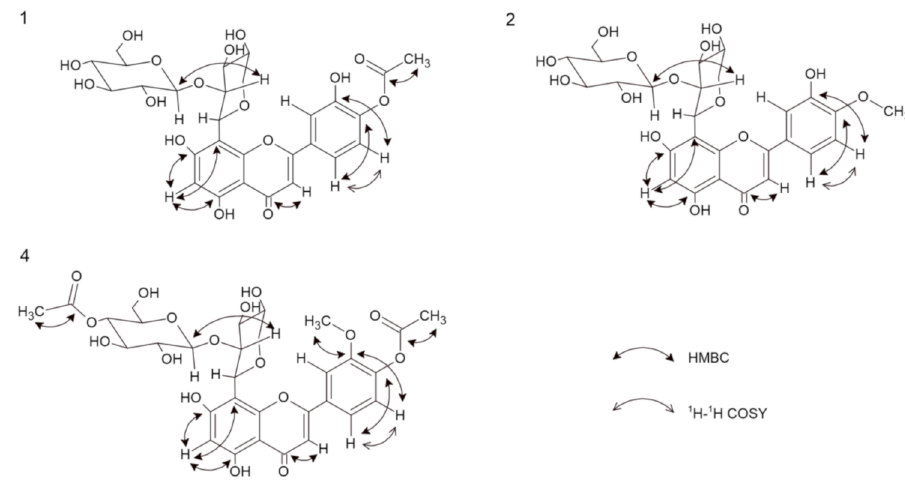
Figure 2. Important 1 H- 1 H COSY and HMBC correlation of compounds 1 , 2 , and 4